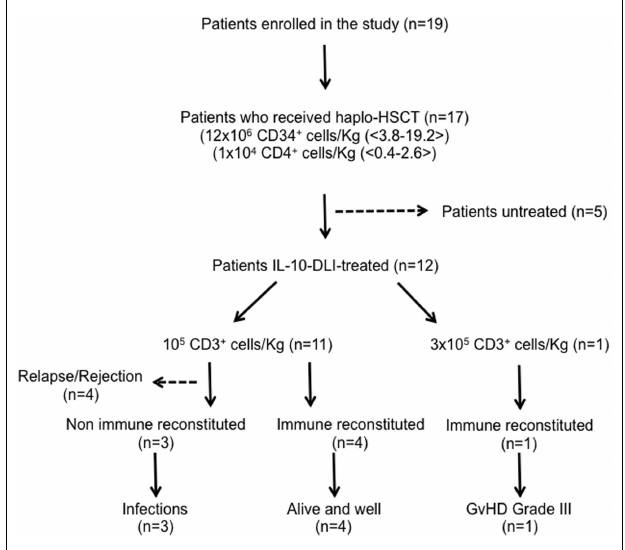
FIGURE 1 | Patients’ distribution and overall outcome of patients enrolled inALT-TEN trial . IL-10-DLI: IL-10-anergized donorT cells; immune reconstituted patients: CD3 + T cells > 100/ µ